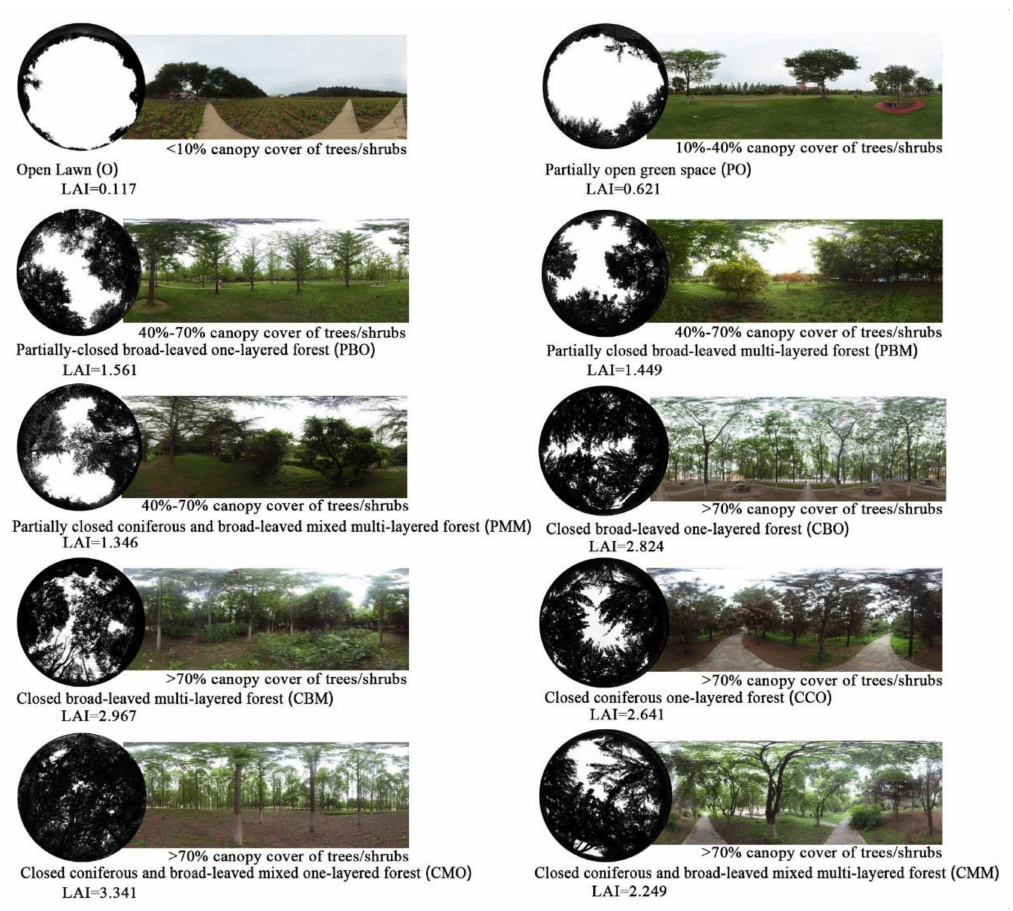
Figure 2. Fisheye camera view of urban green space